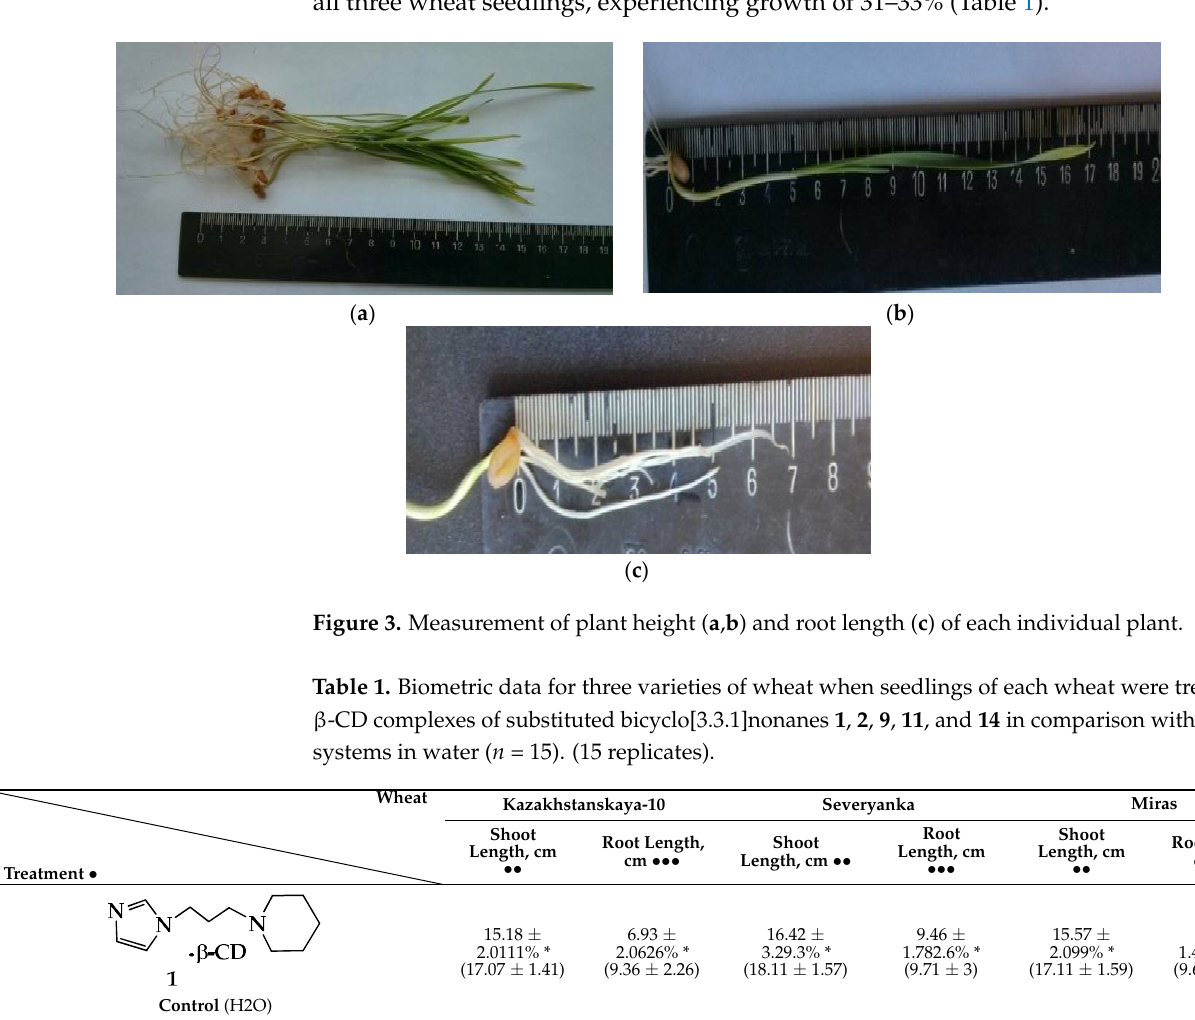
Figure 2. Two-day-old wheat seedlings with pre-sowing treatment with samples 1, 2, 9, 11, and 14.